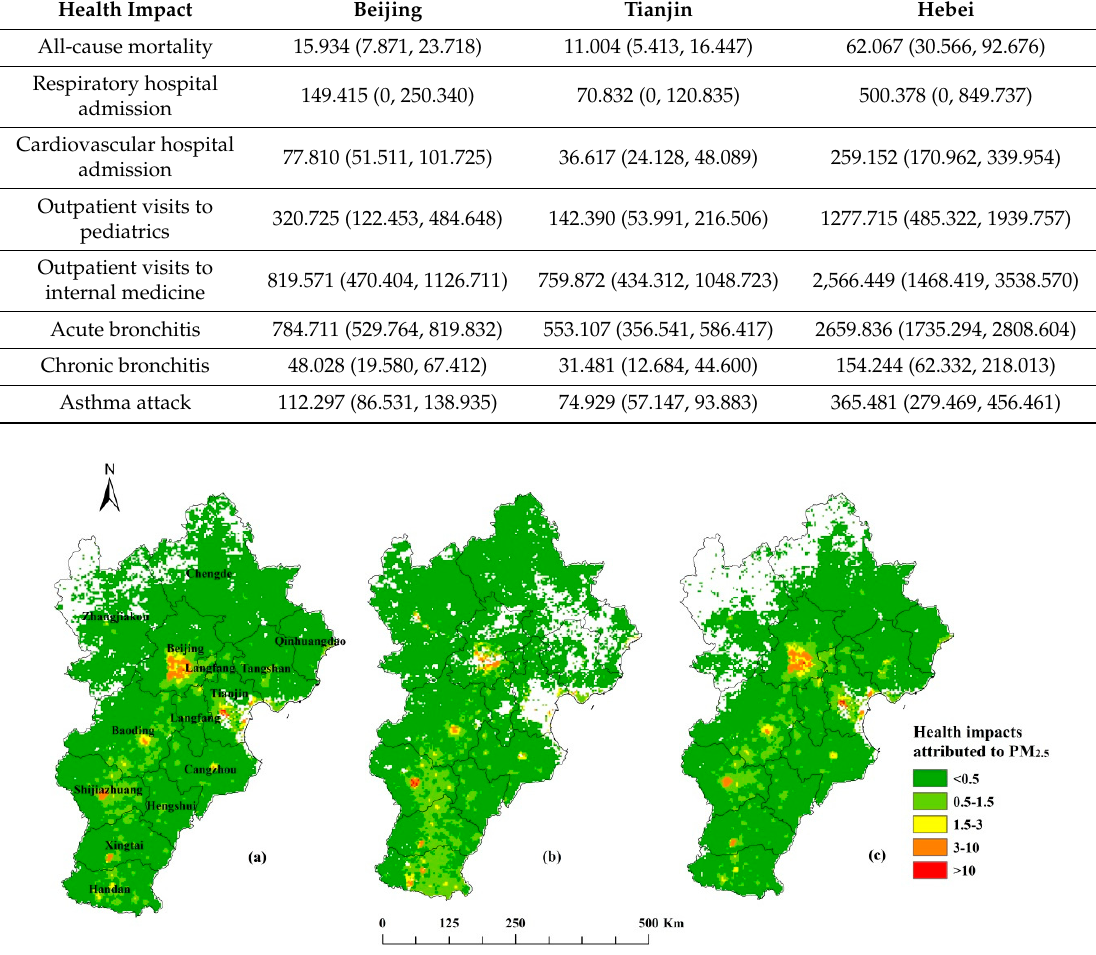
Figure 5. Spatial distribution of the health impacts associated with PM 2.5 in ( a ) 2016, and during the ( b ) cold season and ( c ) warm season of 2016 (unit cases).